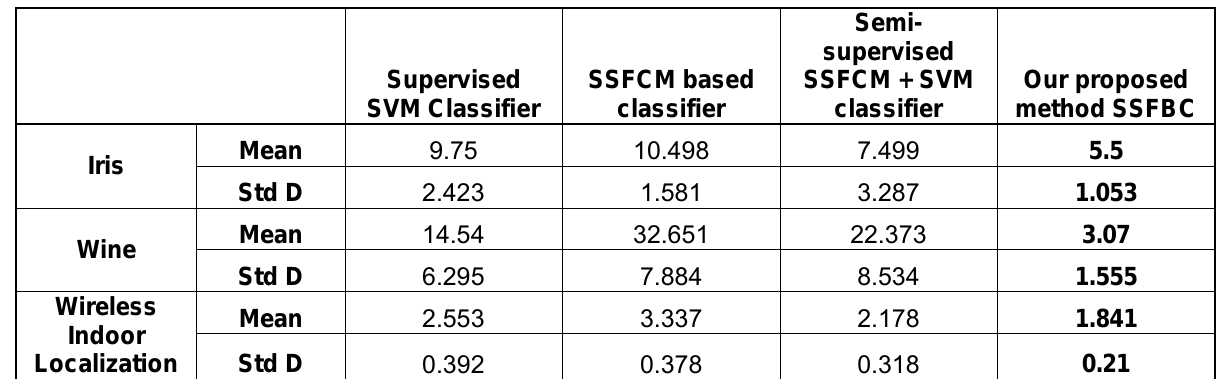
Table 2. Mean and Standard Deviation of Error Rate for SVM, SSFCM, SSFCM integrated with SVM and proposed technique SSFBC